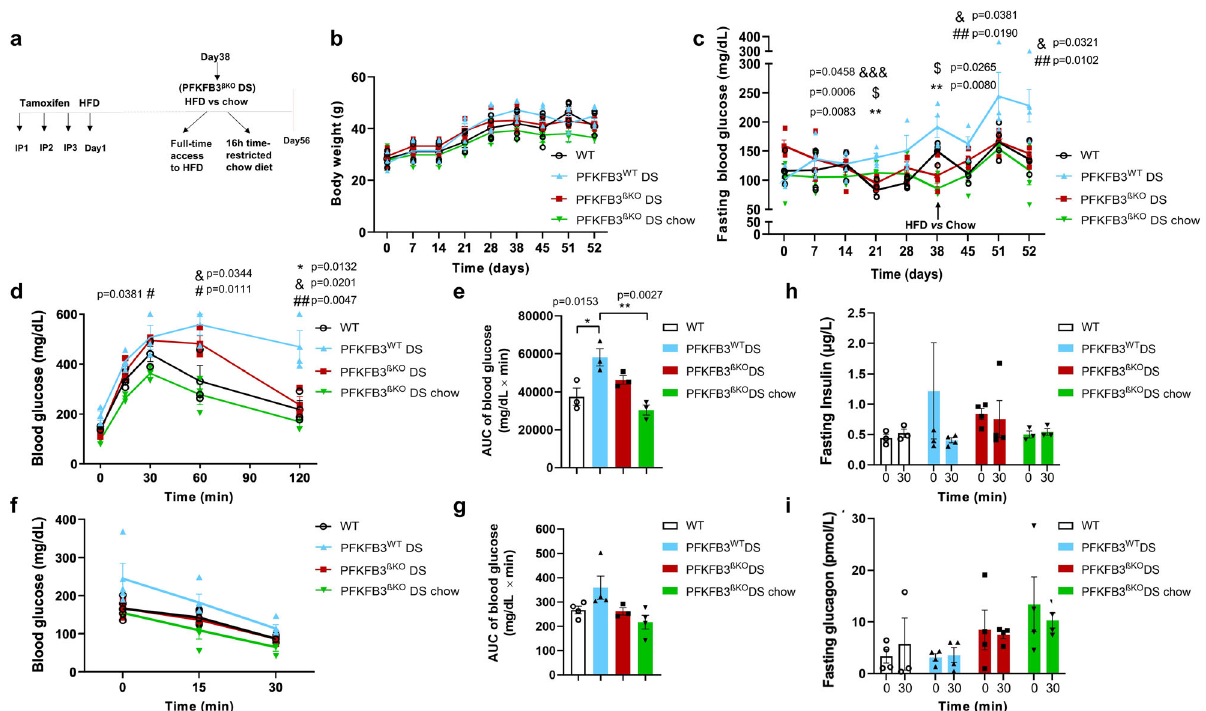
Fig. 3 PFKFB3 β KO DS low mice demonstrate improved glucose tolerance and insulin sensitivity relative to PFKFB3 WT DS low mice. a Scheme of experimental paradigm with lower diabetogenic stress. Intraperitoneal injections 1, 2 and 3 (IP1, 2, 3). Days after onset of HFD are indicated. b Body weight of mice in the experimental groups. c Weekly fasting blood glucose in the indicated experimental groups (* p values for signi fi cant difference between PFKFB3 β KO DS and PFKFB3 WT DS, # p values for signi fi cant difference between PFKFB3 β KO DS chow and PFKFB3 WT DS mice and $ p values for signi fi cant difference between PFKFB3 WT DS and WT are indicated) (see individual values in Supplementary Data File 6). d Intraperitoneal glucose tolerance test (IP- GTT) at 8 weeks post onset of high-fat diet (HFD) ( n = 3 independent experiments, each experiment n = 4 independent animals, SEM) (see individual values in Supplementary Data File 6). e Quanti fi cation of the area under the curve (AUC) as mg/dL x min in the experimental groups in ( d ) (* p =